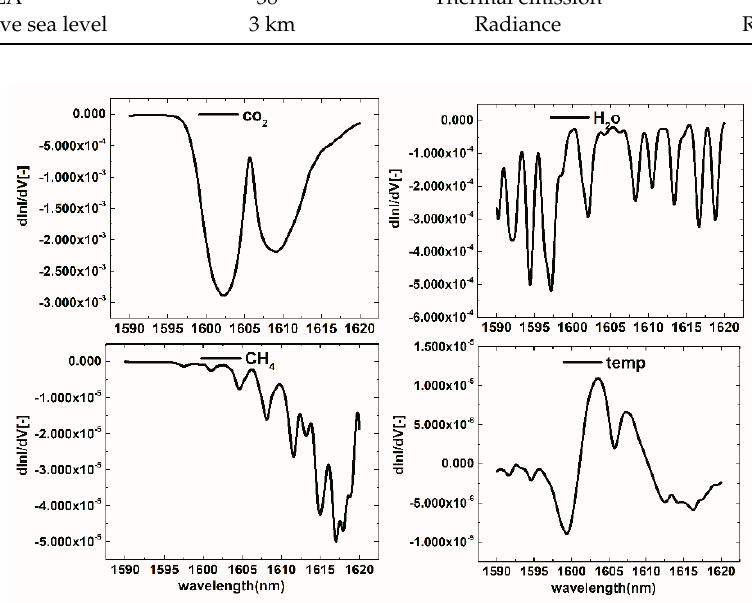
Figure 4. CWF of CO 2 , H 2 O, CH 4 , and temperature.